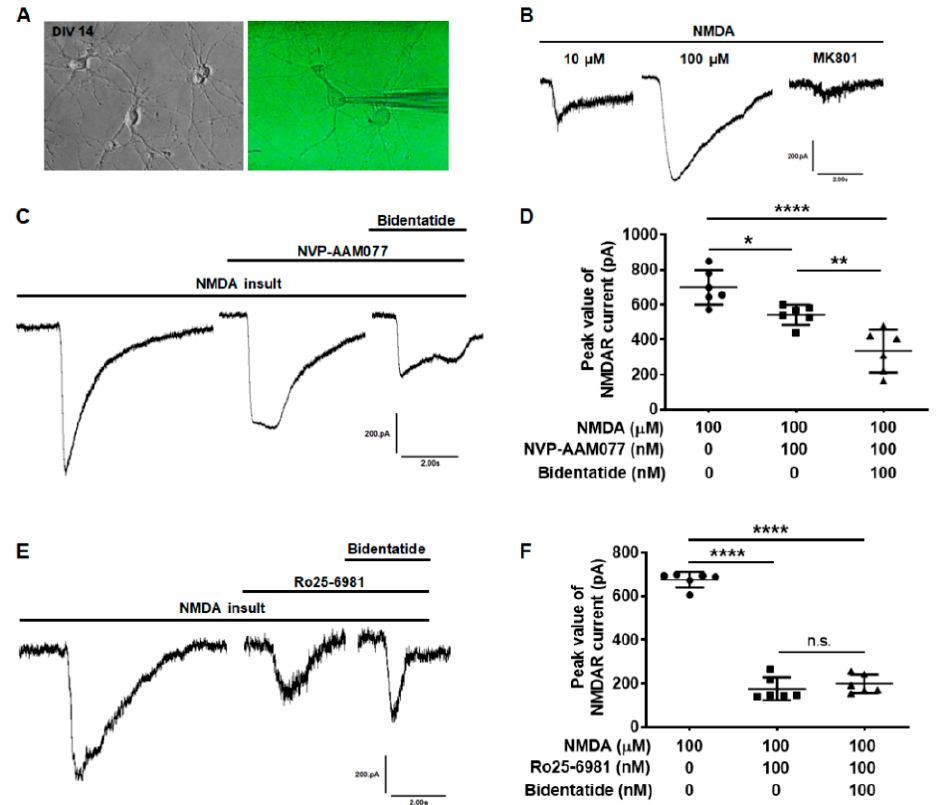
Figure 3. Bidentatide effects on NMDA evoked currents in primary cultured hippocampal neurons: ( A ) the cell morphology of primary cultured hippocampal neurons (DIV14), as observed under phase contrast microscope (left) or as clamped with glass electrode connected to patch clamp amplifier (right); ( B ) effects of MK801 (10 μ M) on NMDA-evoked current; ( C ) effects of bidentatide (100 nM) on NMDA-evoked current with NR2A blocked by NVP-AAM077 (100 nM); ( D ) bar graph showing bidentatide (100 nM) effects on the peak value of NMDA-evoked current with NR2A blocked by NVP-AAM077 (100 nM); **** p < 0.0001, ** p < 0.01, * p < 0.05; ( E ) effects of bidentatide (100 nM) on NMDA receptor current with NR2B blocked by Ro25-6981 (100 nM); ( F ) bar graph showing bidentatide (100 nM) effects on the peak value of NMDA-evoked current with NR2A blocked by Ro25-6981 (100 nM); **** p < 0.0001; n.s. means no significance.